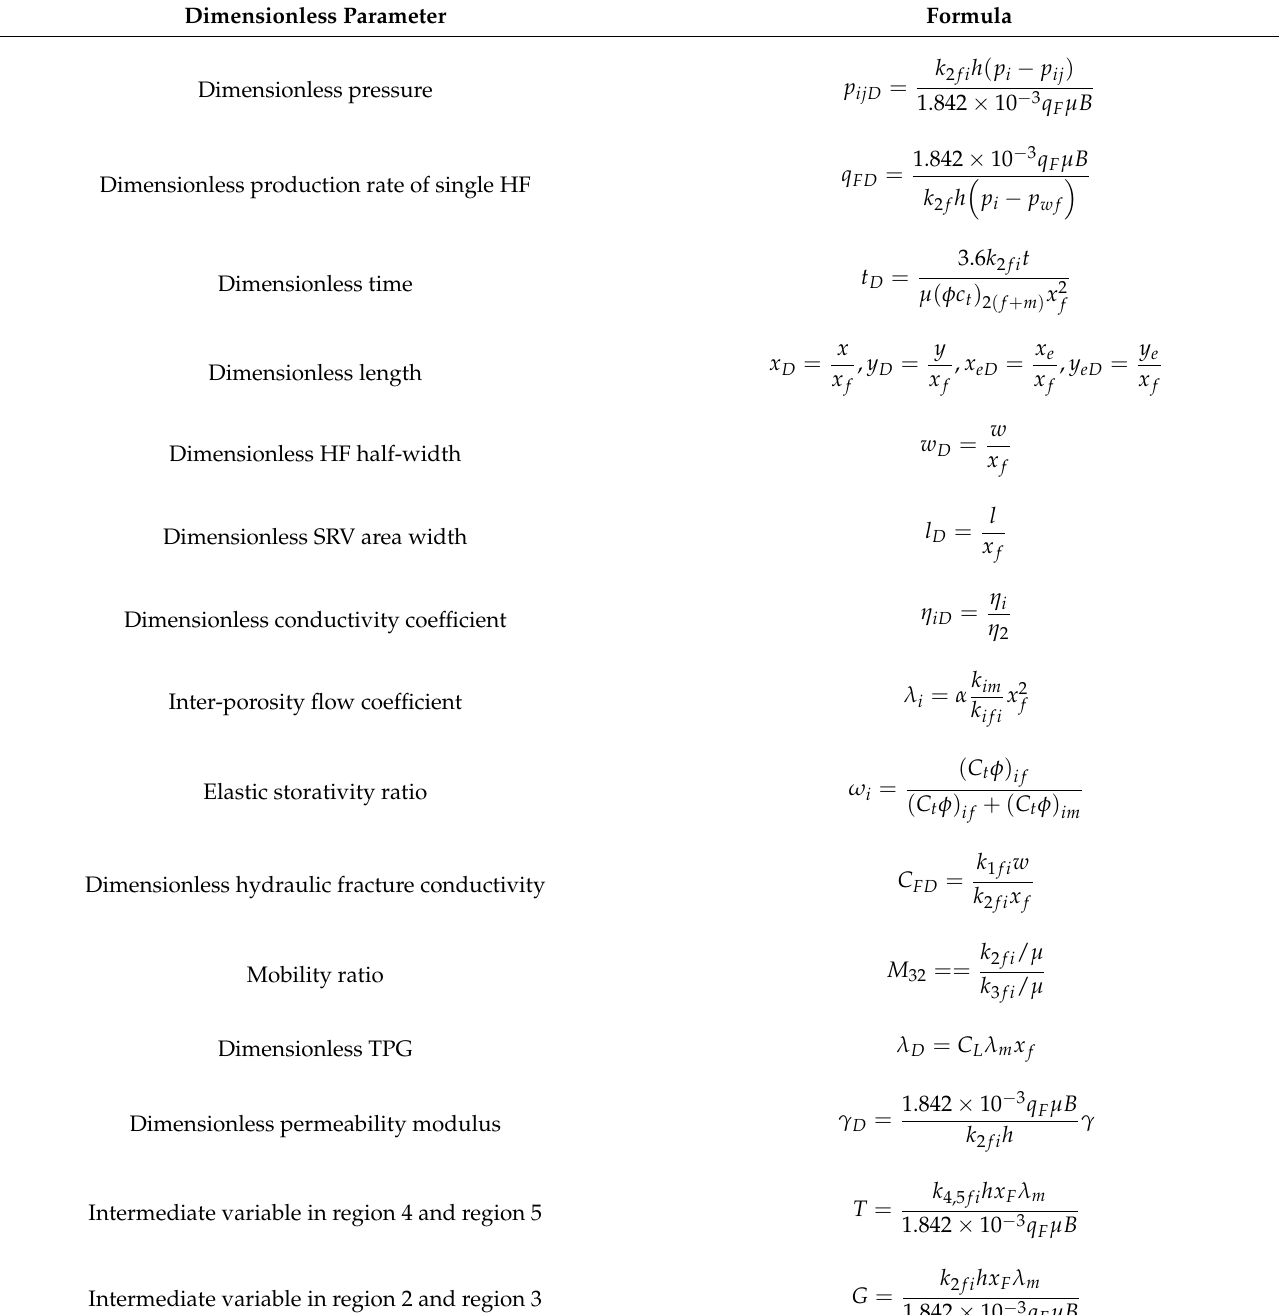
Table 2. Dimensionless